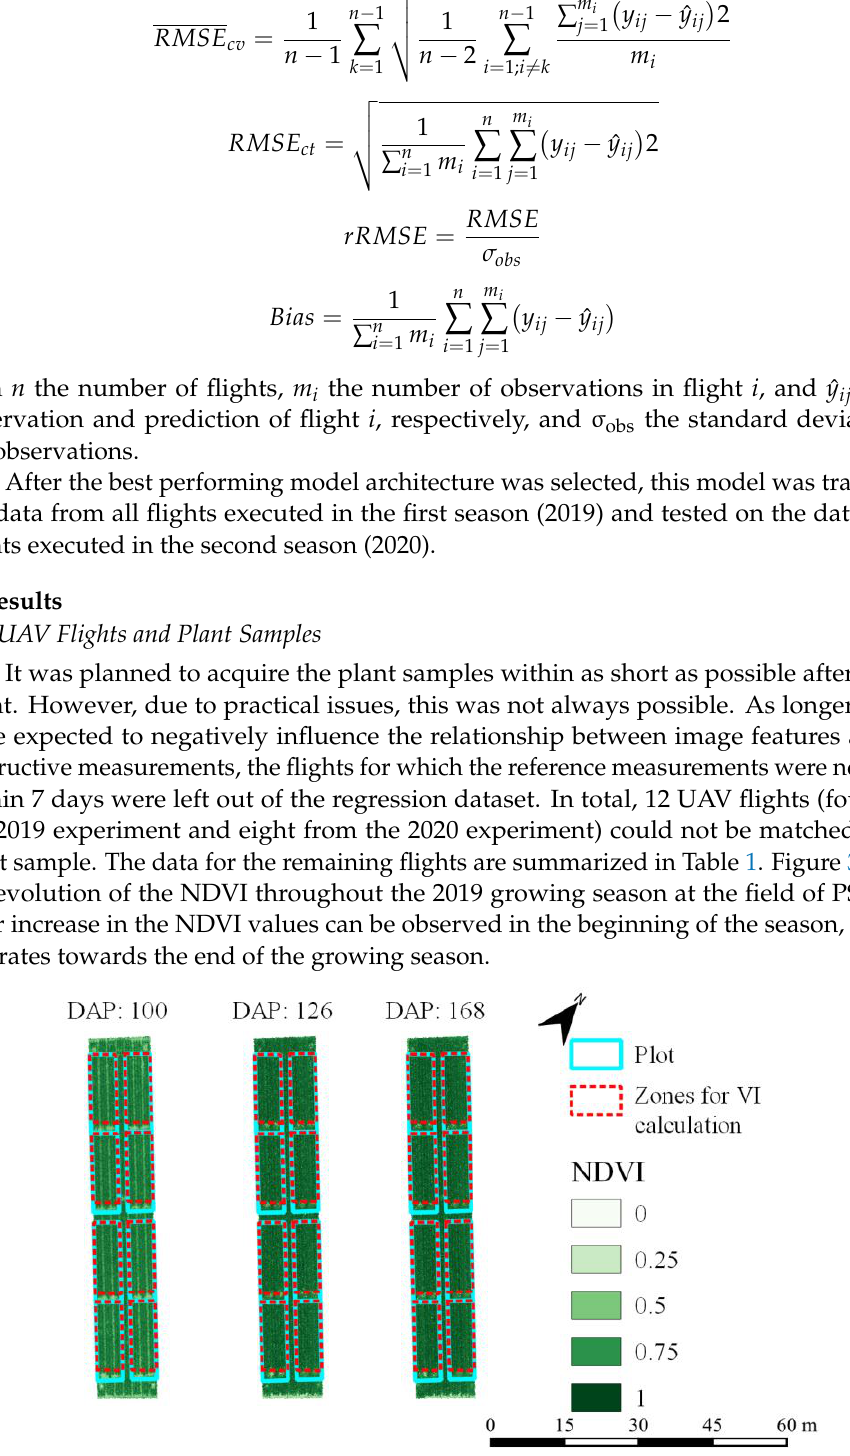
Figure 3. Evolution of the NDVI values acquired at the field of PSKW during the 2019 growing season. The cyan rectangles indicate the complete experimental plot while the red rectangle indicates the area used to extract the multispectral data.